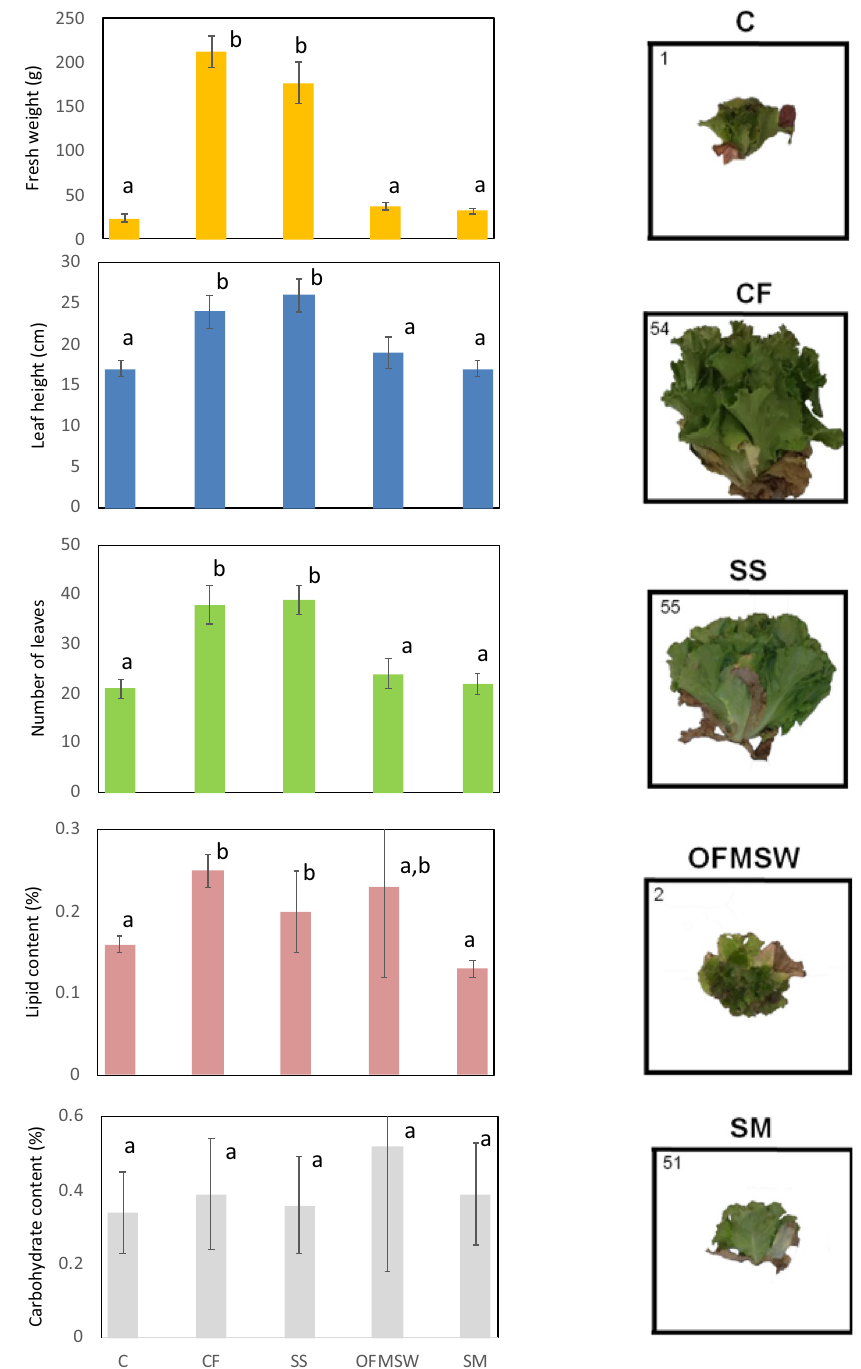
Figure 1. Phenotypic parameters of the lettuce plants grow under the different organic fertilizers, including control without fertilization (C) and control with chemical fertilization (CF) (n = 5). Different letters between treatments in the plots indicate statistical differences ( p < 0.05). Pictures of the lettuce plants grown on the different organic fertilizers, including C and CF, and the following organic amendments. SS: sewage sludge; OFMSW: organic fraction of municipal solid waste; and SM: swine manure. Plot was created with Microsoft Excel (version16.6.6, https:// www. micro soft.